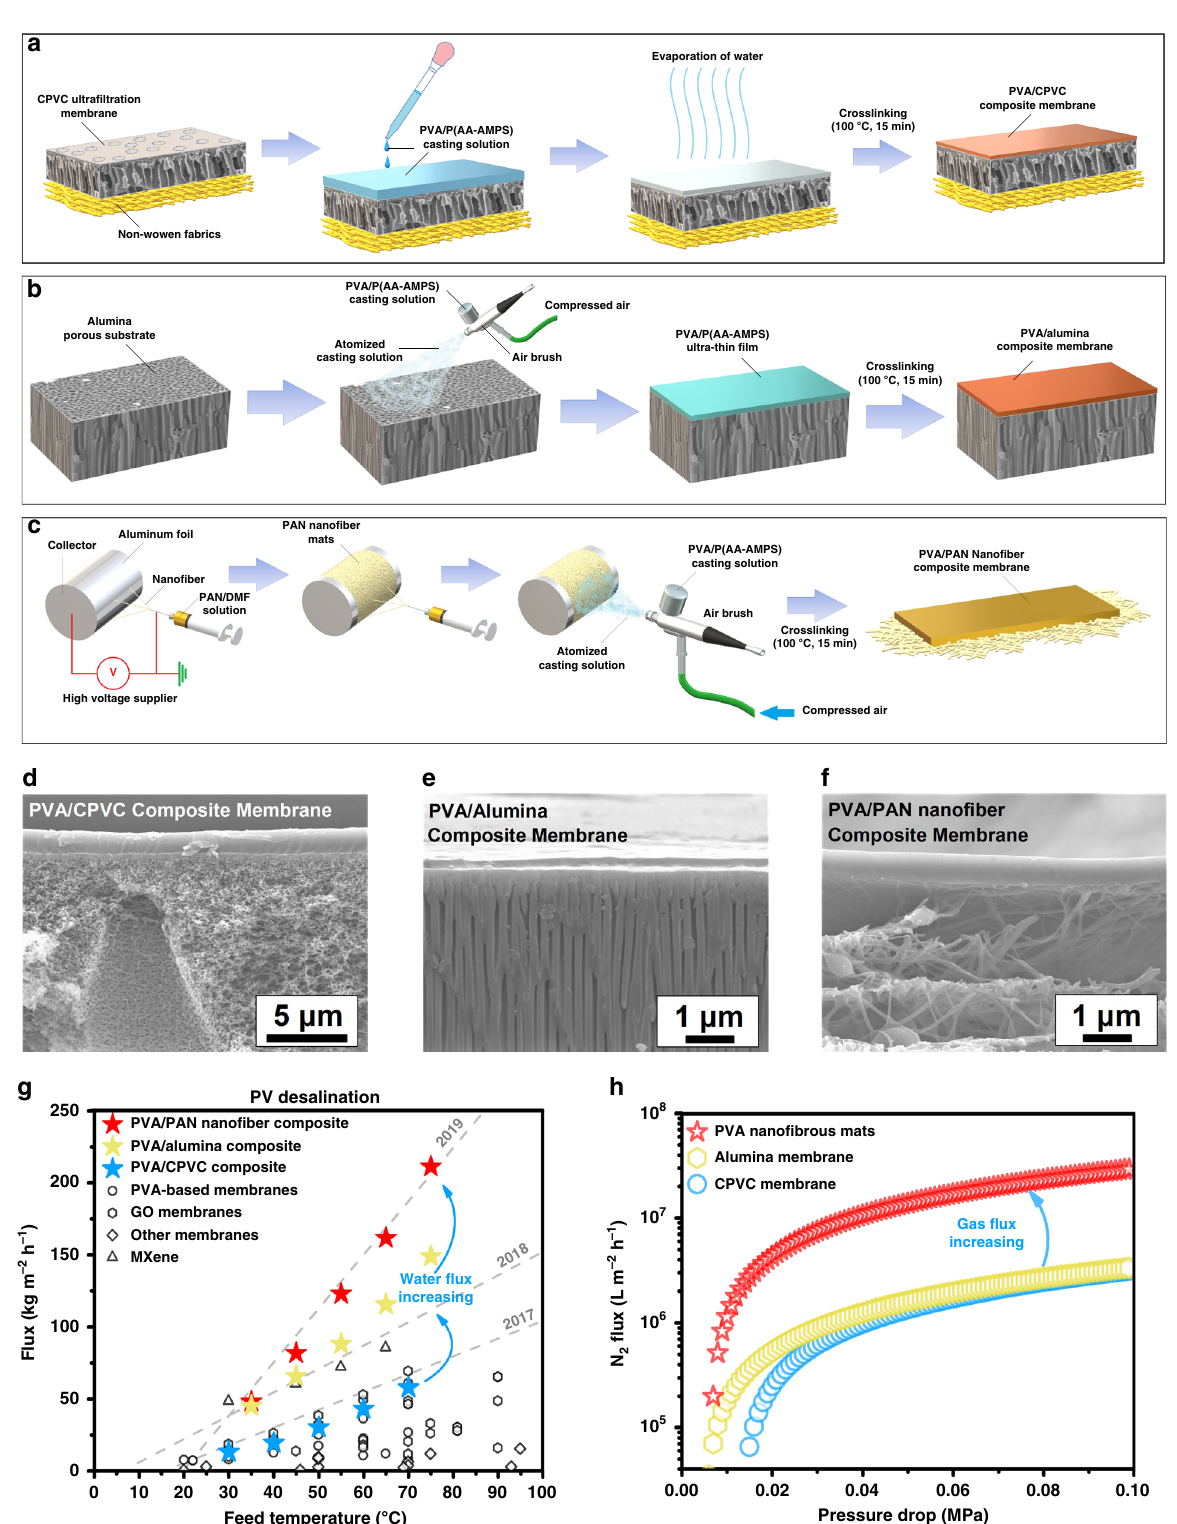
Fig. 3 Preparation protocols and desalination performance of PV membranes. Preparation protocols and cross-sectional morphologies of composite membranes: a , d PVA/CPVC; b , e PVA/Alumina; c , f PVA/PAN nano fi ber mats. g Comparison of desalination performances of our PV membranes with the reported data (Supplementary Table 9). h Relationships between N 2 fl uxes (L m − 2 h − 1 ) and pressure drops (MPa) of the porous substrates used in this